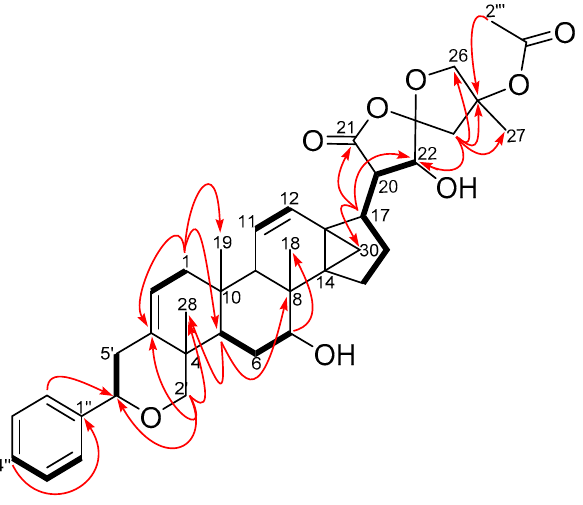
Figure 2. COSY (bold bonds) and some key HMBC (curved arrows) correlations of compound 1 (Supplementary Materials S4 and S6).